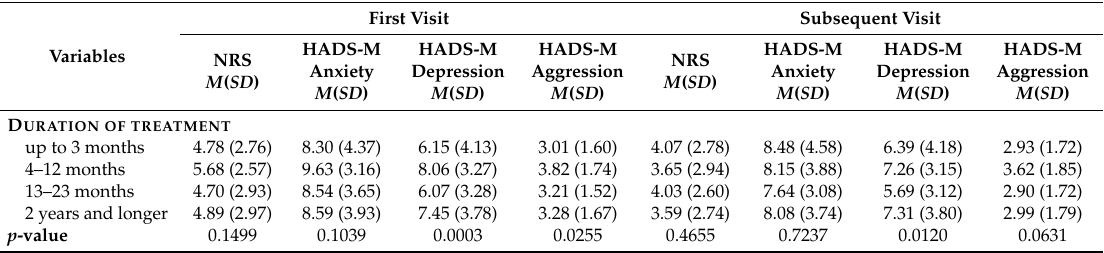
Table 5. Statistical analysis of pain intensity and emotional disturbances during the first and subsequent visit at the pain clinic depending on the duration of treatment of the patients